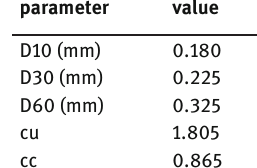
Table 1: Granulometric proprieties of Biskra Silica Sand.